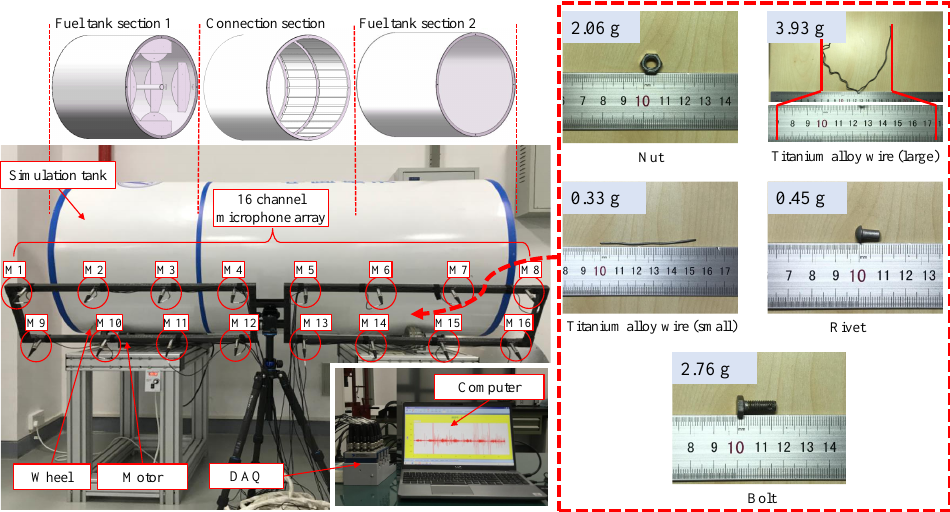
Figure 5. The test bench of sound-based detection for